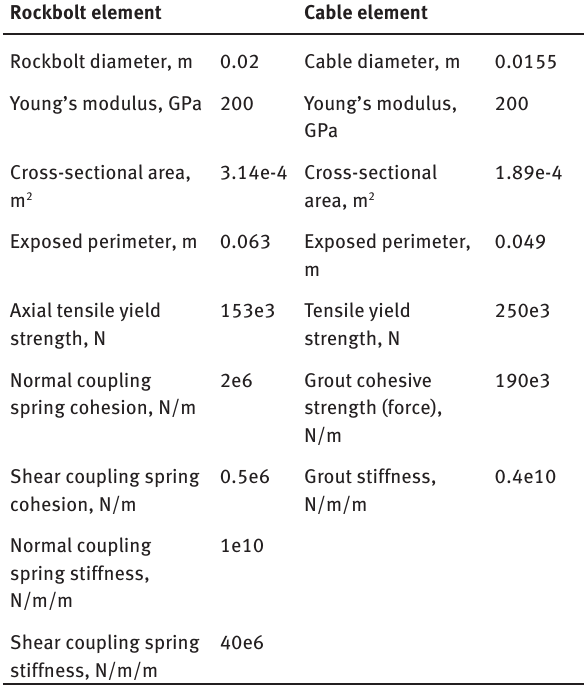
Figure 9: Sketch of the LINK-N-LOCK box crib: a) top view, b) dimensions of a single Table 3: Cable element and rockbolt element properties.